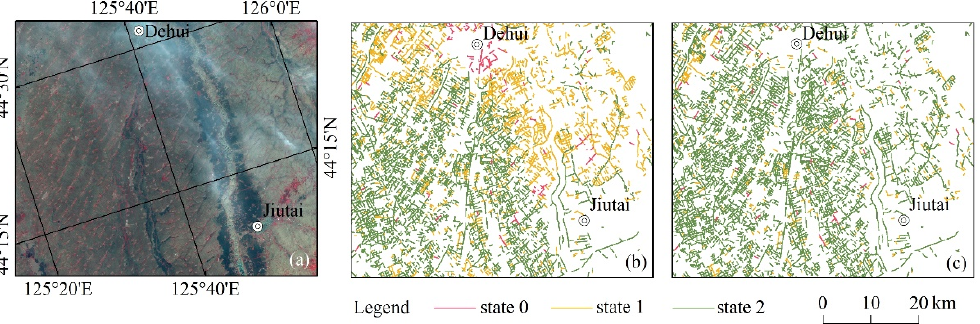
Figure 7. The comparison of the farmland shelterbelt states before and after modification ( a ). the Landsat image with cloud cover; ( b ). the shelterbelt states without modification; ( c ). the shelterbelt states modified by the rules of three-stage growth process and shelterbelt states in the previous and subsequent